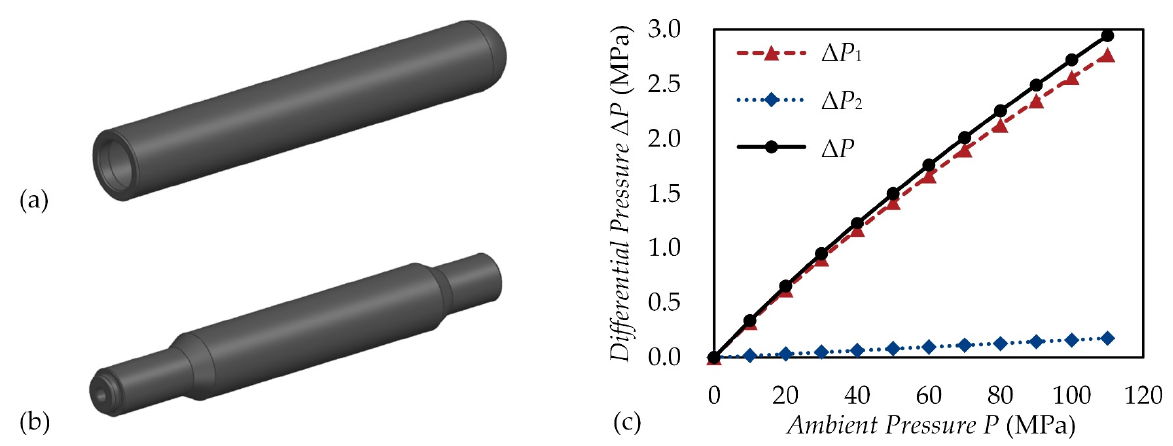
Figure 4. A 3D view of ( a ) the primary resilient bladder and ( b ) the secondary resilient bladder, and ( c ) the change curves of the differential pressures in the proposed wet-mateable electrical